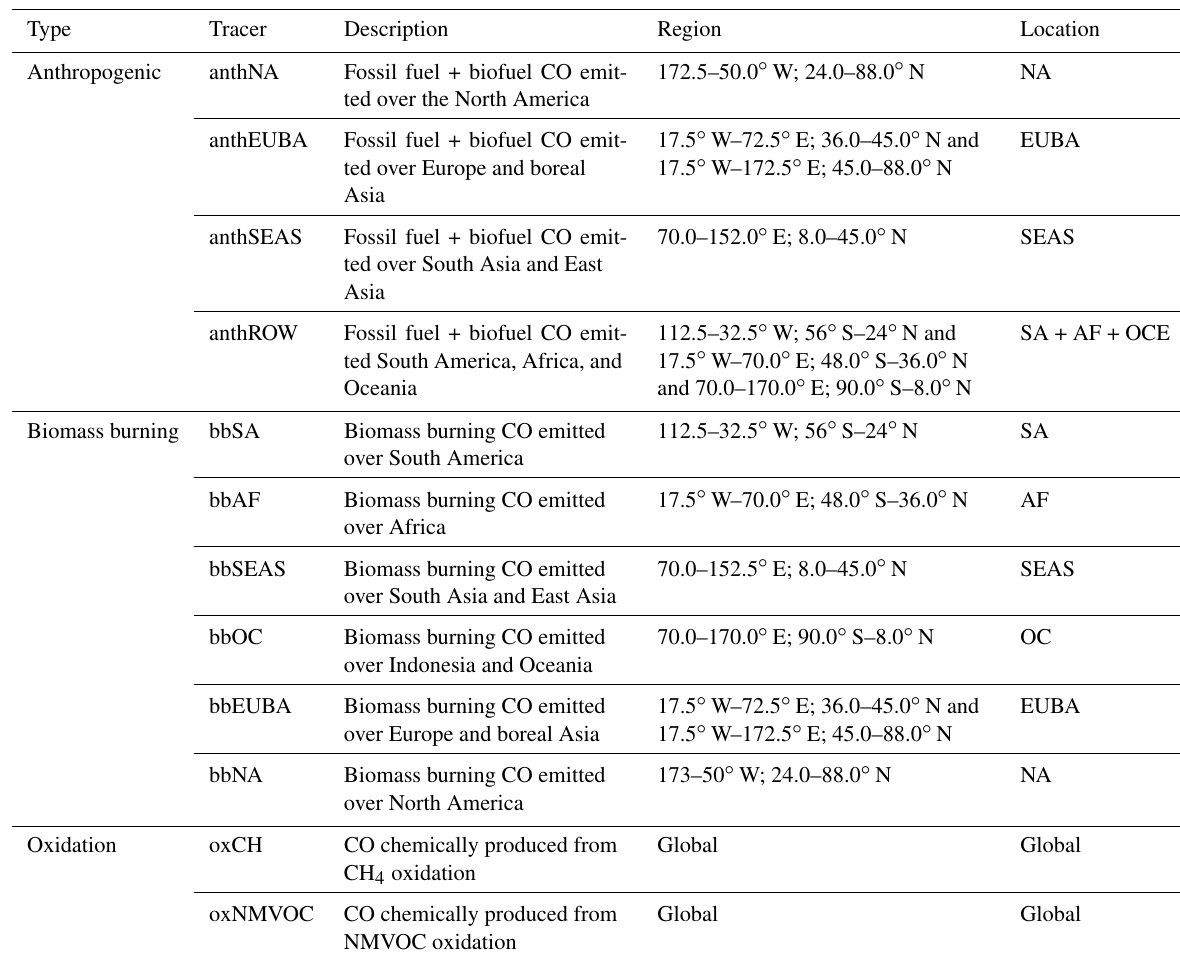
Table 2. Descriptions of all tracers implemented in the standard GEOS-Chem tagged CO simulation and the geographical definitions of all source